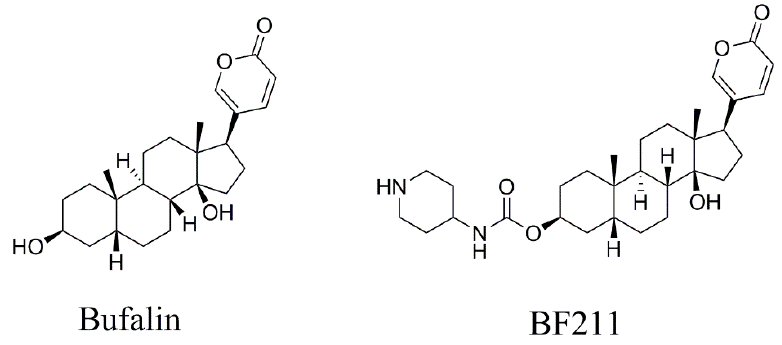
Figure 1. The chemical structures of bufalin and BF211.